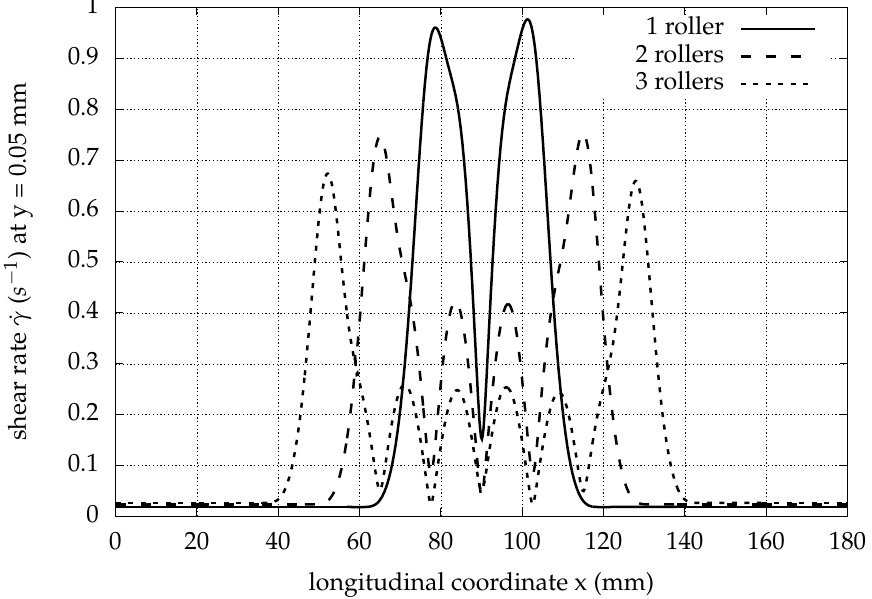
Figure 18. Shear rate near the central axis of the pump ( y = 0.05 mm) for various numbers of rollers. The roller speed is c = 5 mm/s, the relative occlusion is RO = 0.6 and the Bird–Carreau power index is n = 1. The shear rate profiles for a series of vertical sections are given in Figure